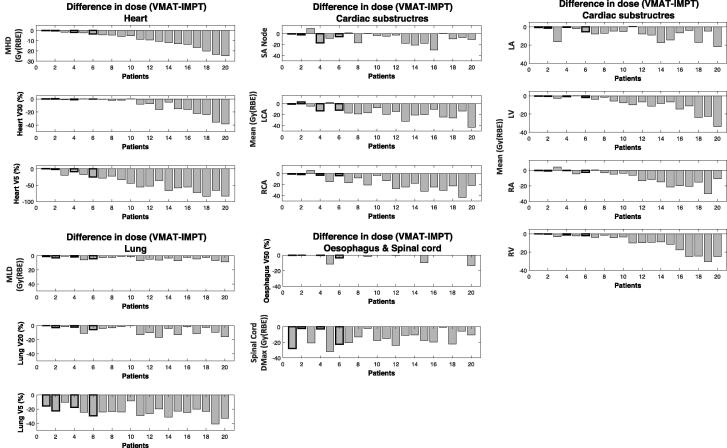
Difference in doses to OAR. Patients marked in bold box (pt 1, 2, 4 and 6) indicate those with tumour not extending to and below T7 vertebrae.